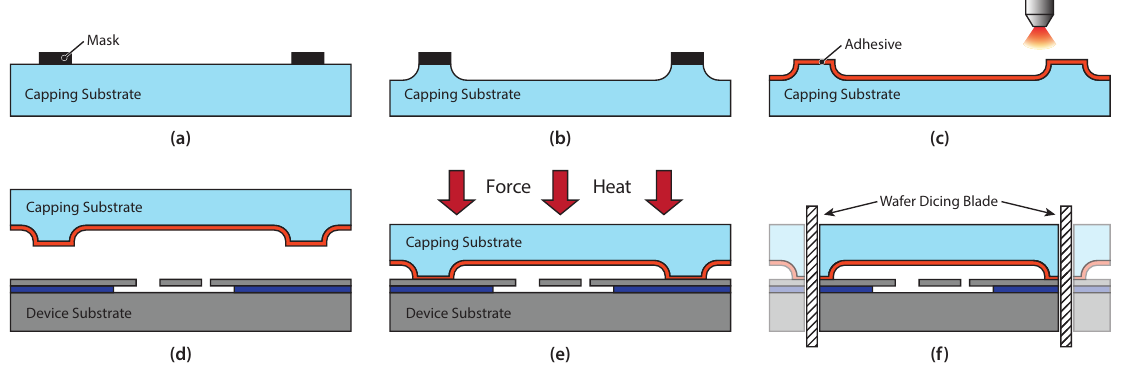
Figure 1. Schematic process flow of the proposed capping method. ( a ) Patterning of a mask on the capping substrate; ( b ) Etching of the cavities and stripping of the mask; ( c ) Deposition of a thin layer of polymer adhesive by spray-coating; ( d ) Alignment of the capping substrate and the device substrate and moving them in contact; ( e ) Adhesive wafer bonding by applying a force to the wafer stack and raising the temperature to cure the polymer adhesive; ( f ) Die singulation by wafer